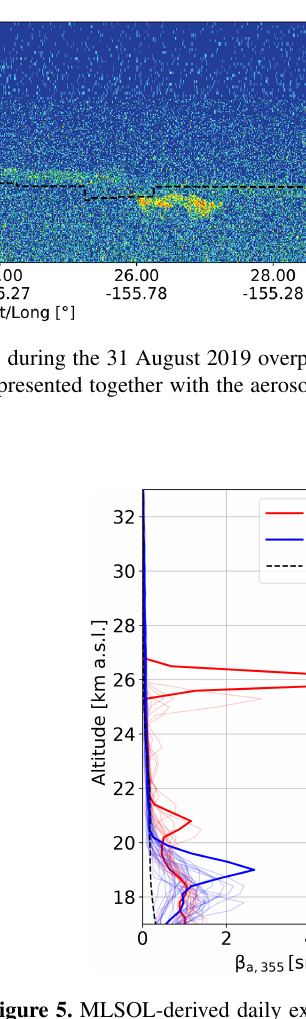
Figure 5. MLSOL-derived daily extinction coefficient profiles for September and October 2019 (solid light red). The extinction co- efficient profile for 24 September 2019 is highlighted (solid red). For comparison, the MLSOL-derived daily profiles of the Nabro plume between the end of July 2011 and January 2012 are presented (solid light blue), with the most prominent profile highlighted (solid blue). As background aerosol reference, the monthly averaged ex- tinction profile for June 2019 (black dashed) before the detection of the Raikoke–Ulawun plume is also